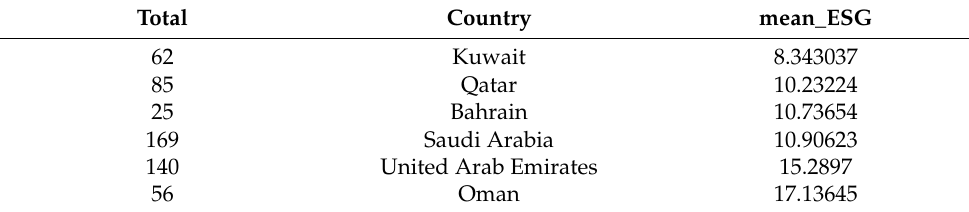
Table 4. Comparison between countries in terms of